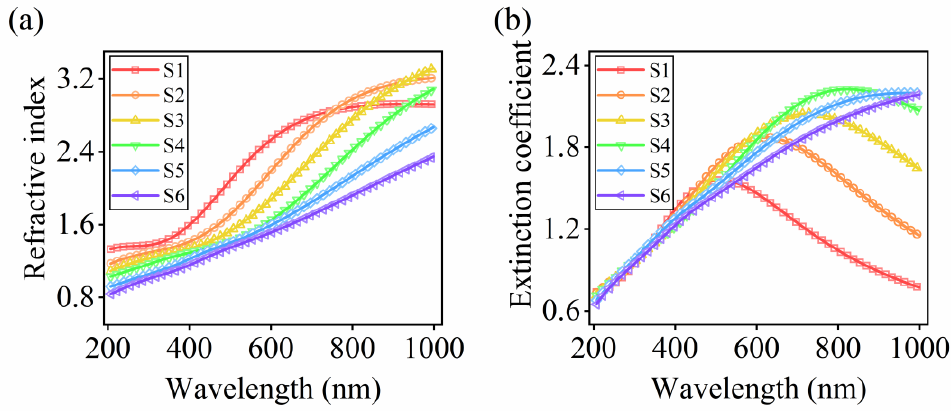
Figure 3. ( a ) Refractive index and ( b ) extinction coefficient of indium-particle films S1 –